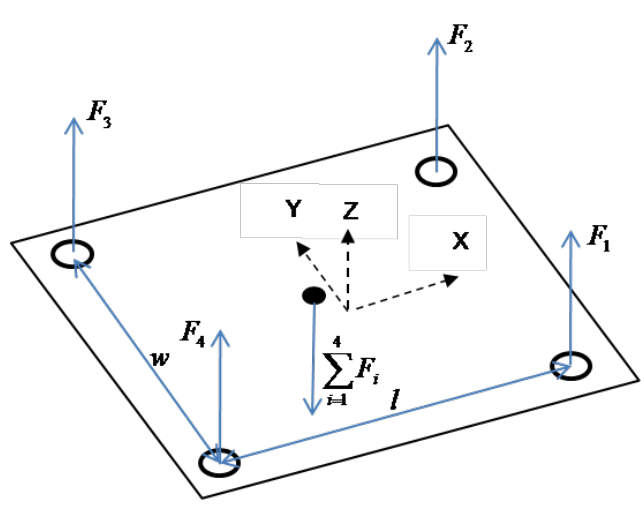
Figure 1. Center-of-pressure (COP) calculation in a 3D Cartesian coordinate system.